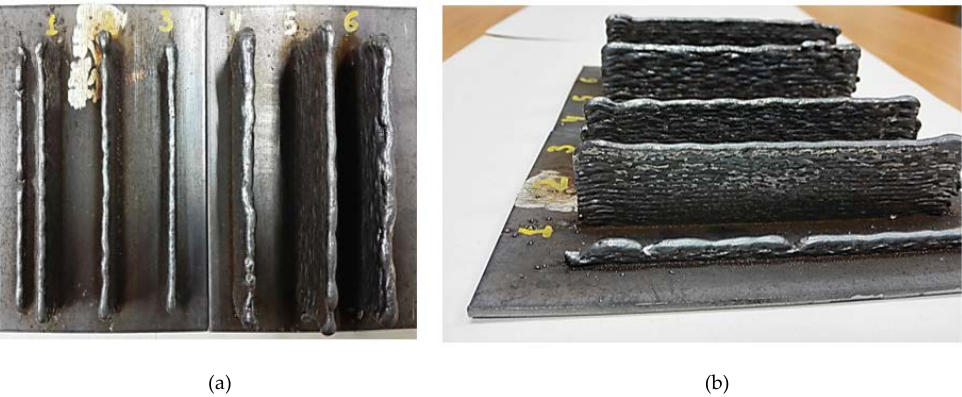
Figure 3. Manufacturing of samples nº 1 to 6: ( a ) Top view; ( b ) Lateral view.